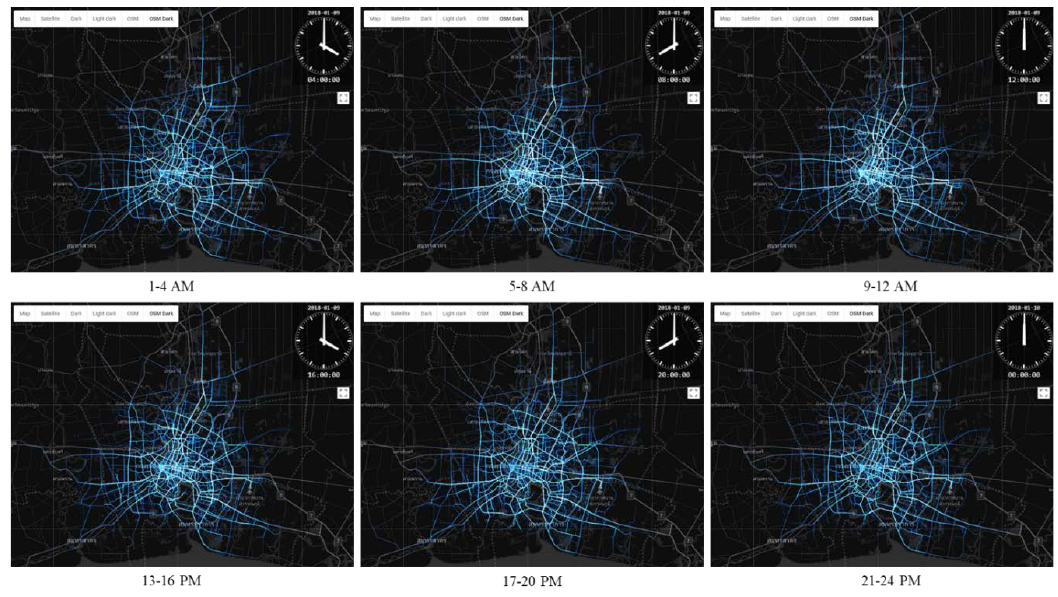
Figure 21. Simulated taxi agent trajectory visualization for weekday at 4 h time intervals.